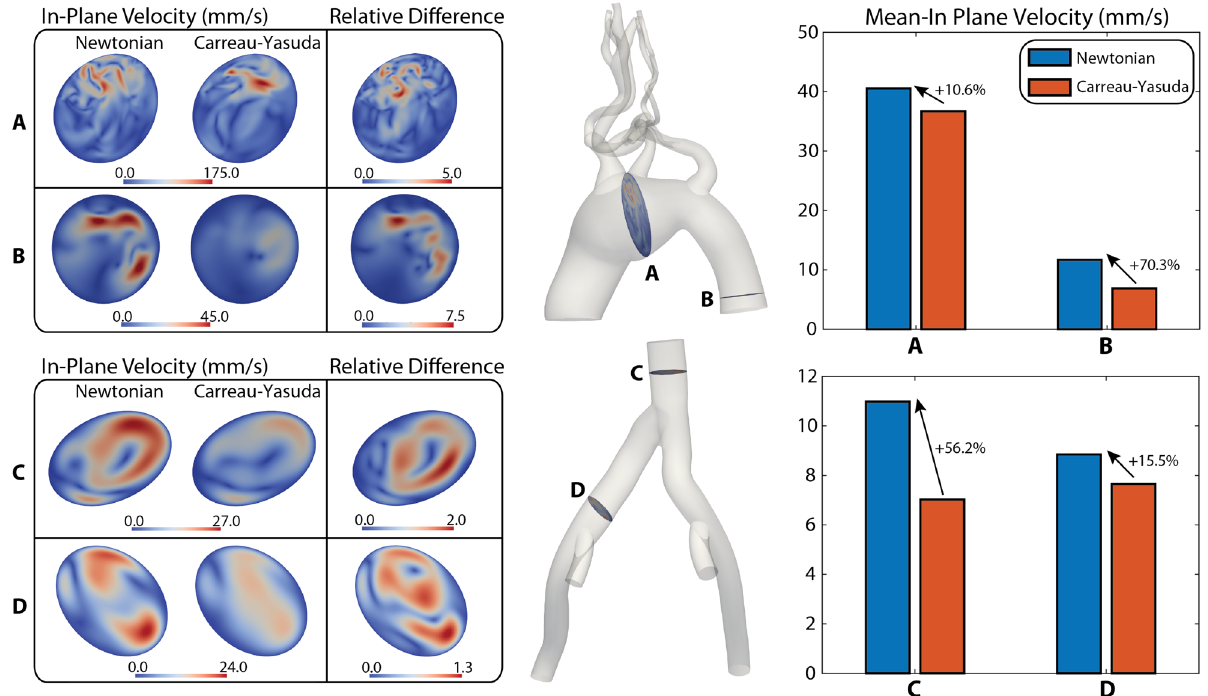
Figure 2. Arterial and venous in-plane velocity in diastole. (Left) Contour plots of in-plane velocity magnitude for the Newtonian and Carreau-Yasuda models, and relative difference between the two, at four representative locations. (Right) Bar plots of mean values for each